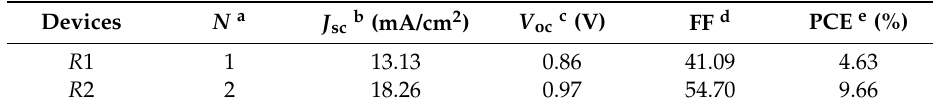
Table 1. Summary of J – V characteristics of device R 1 and device R 2 from reverse